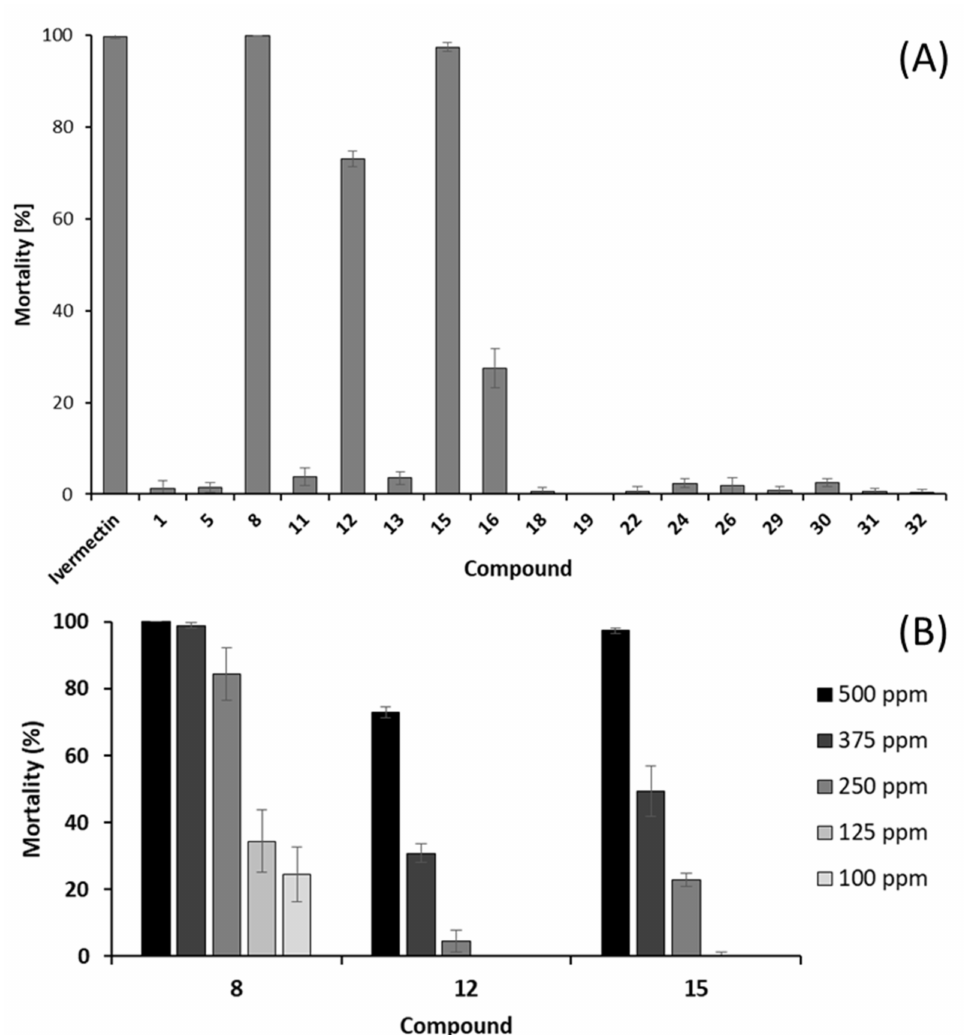
Figure 5. ( A ) Screening of anthelmintic activity against Caenorhabditis elegans of isolated compounds at 500 ppm. ( B ) Anthelmintic activity against C. elegans of methyl 3-(4-methoxyphenyl)propionate ( 8 ), isoasarone ( 12 ), and trans -asarone ( 15 ). Positive control ivermectin 10 µ g/mL killed 100% of the nematodes. Mortality % based on three